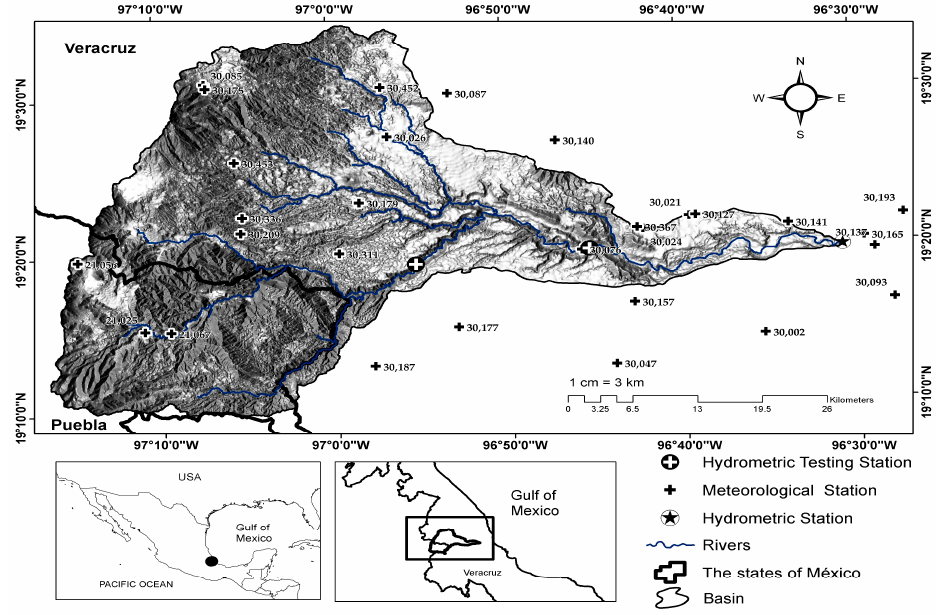
Figure 1. Location of the upper basin La Antigua in the central Gulf of Mexico and stations: meteorological and hydrometric [13].